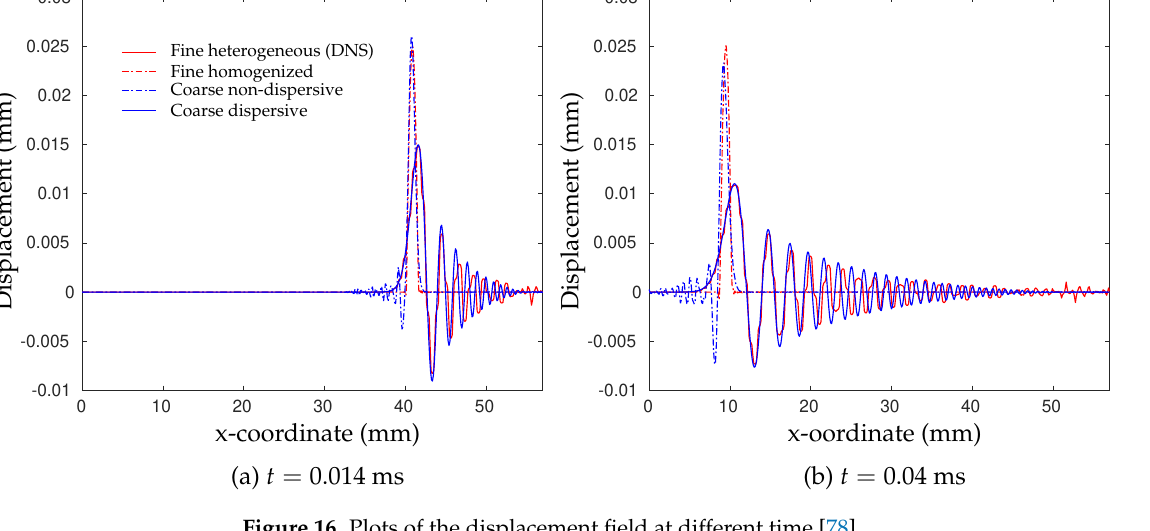
Figure 17: plots of displacement field at di ff erent time [ ? ]. 14